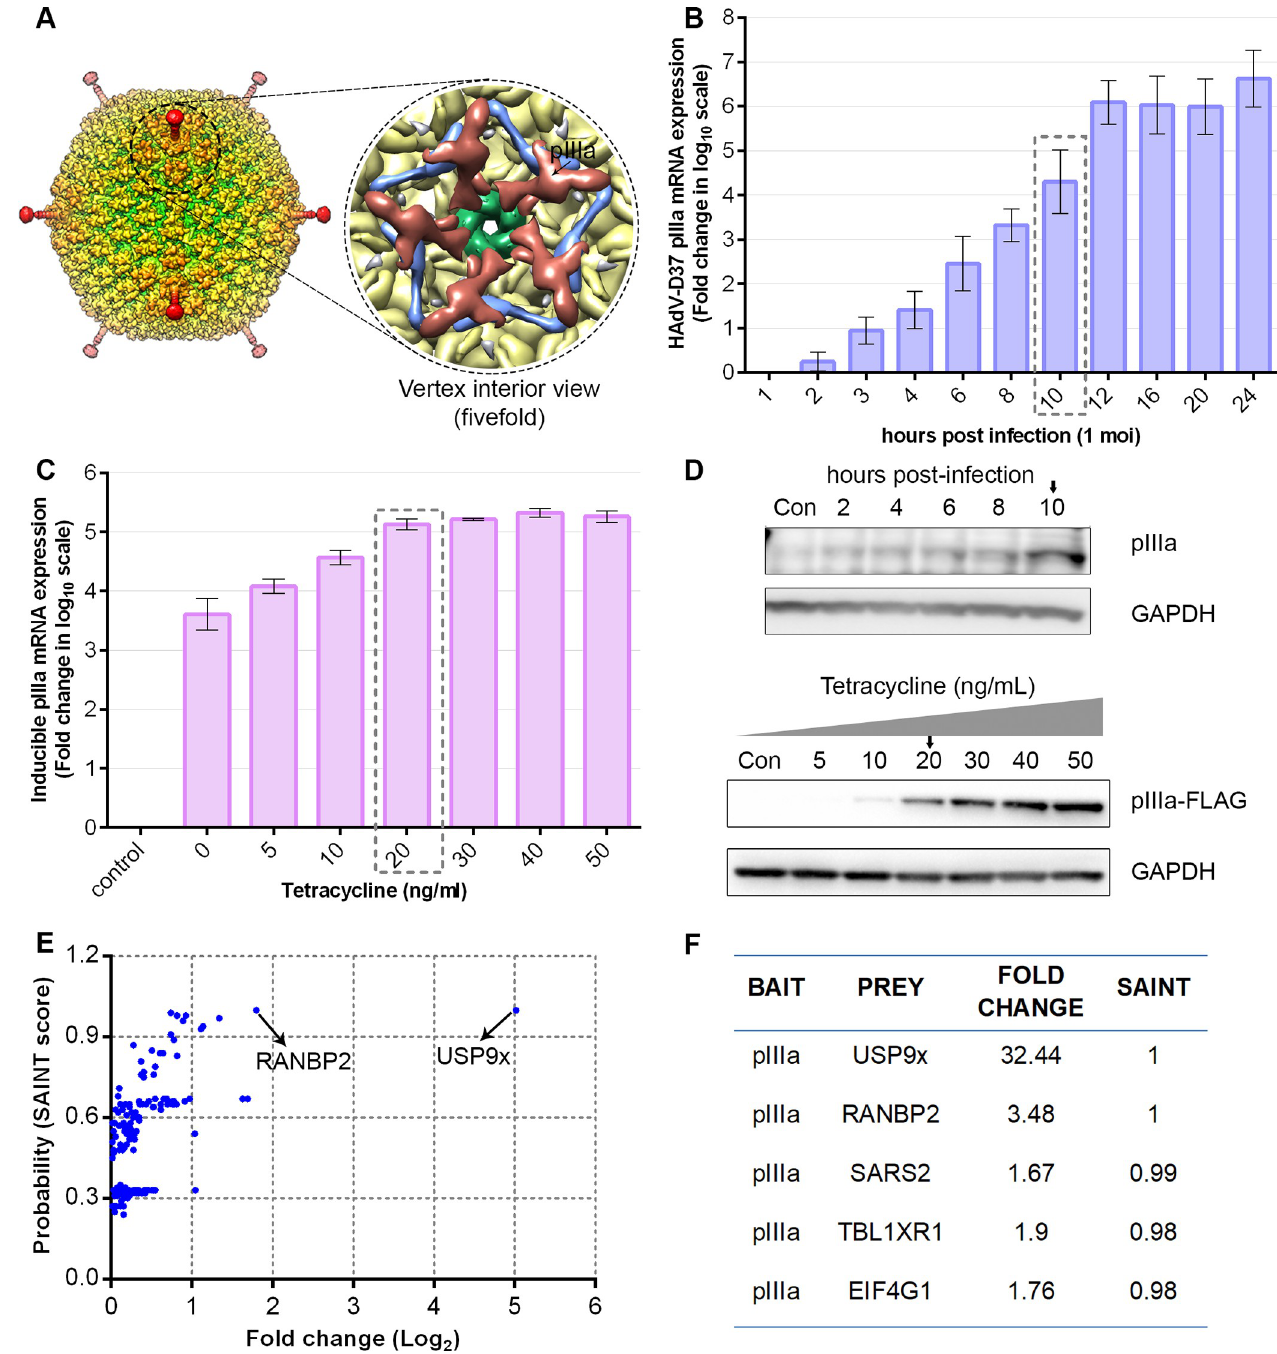
Fig 1. Human adenovirus (HAdV) pIIIa expression and affinity purification-MS/MS analysis. (A) Surface representation of HAdV-D26 (PDB: 5TX1) colored by radius [33] with expanded zoom into the vertex interior view, rendered using UCSF Chimera v1.14. Protein IIIa (pIIIa) (brick red), penton base (green), peripentonal hexons (pale gold), and protein VIII (purple). (B) HAdV-D37 pIIIa mRNA expression levels in HEK293 cells at multiplicity of infection (MOI) of 1 through 24 hrs post infection (hpi). (B and C) Viral pIIIa mRNA expression levels seen in virus-infected cells and stable pIIIa expression in Flp-In 293 T-REx cell lines with tetracycline induction. B and C data shown represents the mean ± standard deviation. (D) Western blot showing pIIIa expression in HEK293 cells infected at an MOI of 1 (upper panel), and pIIIa-Flag protein expression in Flp-In 293 T-Rex cells upon tetracycline induction (lower panel). (E) pIIIa-FLAG and FLAG-control immunoprecipitated protein complexes were TCA precipitated, and LC-MS/MS performed. The obtained mass spectrometry protein interactions analyzed using the CRAPome database identified two high confidence interactors: USP9x and RANBP2. (F) Compared to the experimental and database controls, further analysis of FLAG-pIIIa interactions showed a 32.4 and 3.5 fold change (FC) difference for USP9x and RANBP2, respectively, with a SAINT probability score 1 (100%). Data for B to F were obtained from at least 3 replicate experiments. https://doi.org/10.1371/journal.ppat.1010588.g001 PLOS Pathogens| https://doi.org/10.1371/journal.ppat.1010588 June 16,